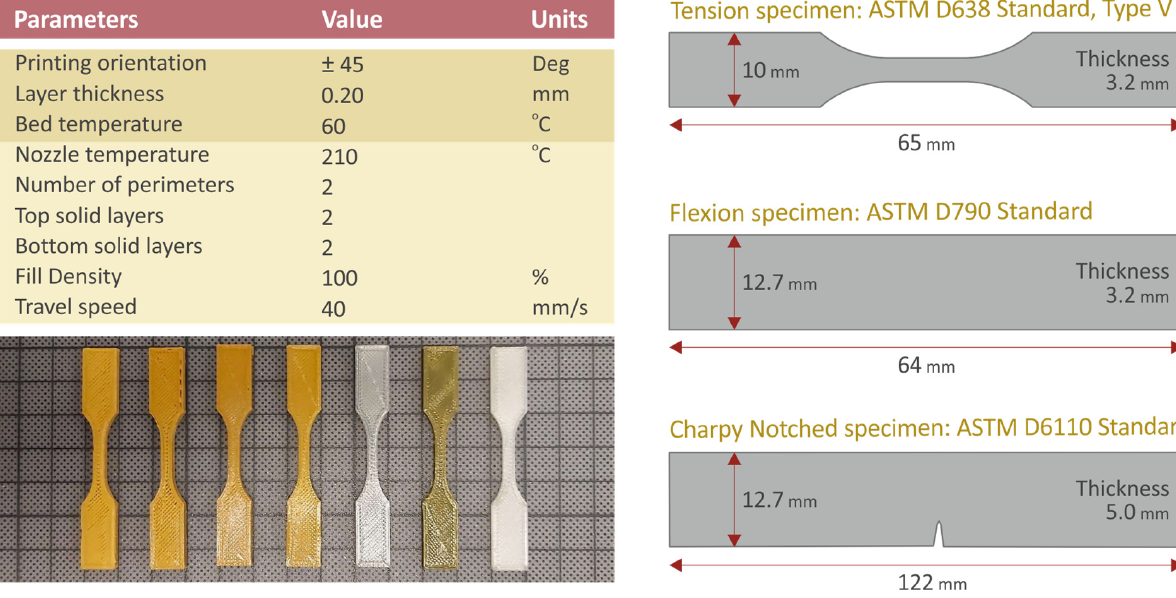
Figure 3. 3D printing settings and specimen geometry according to international standards.